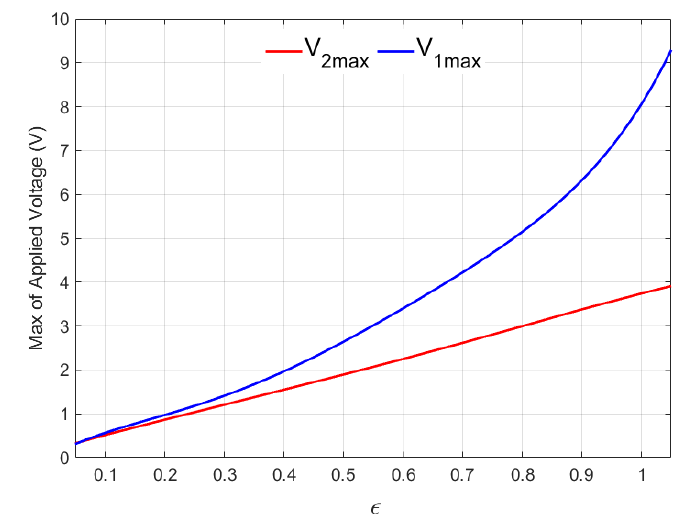
V V 0.05 1.05 ε≤ ≤ and 2 for